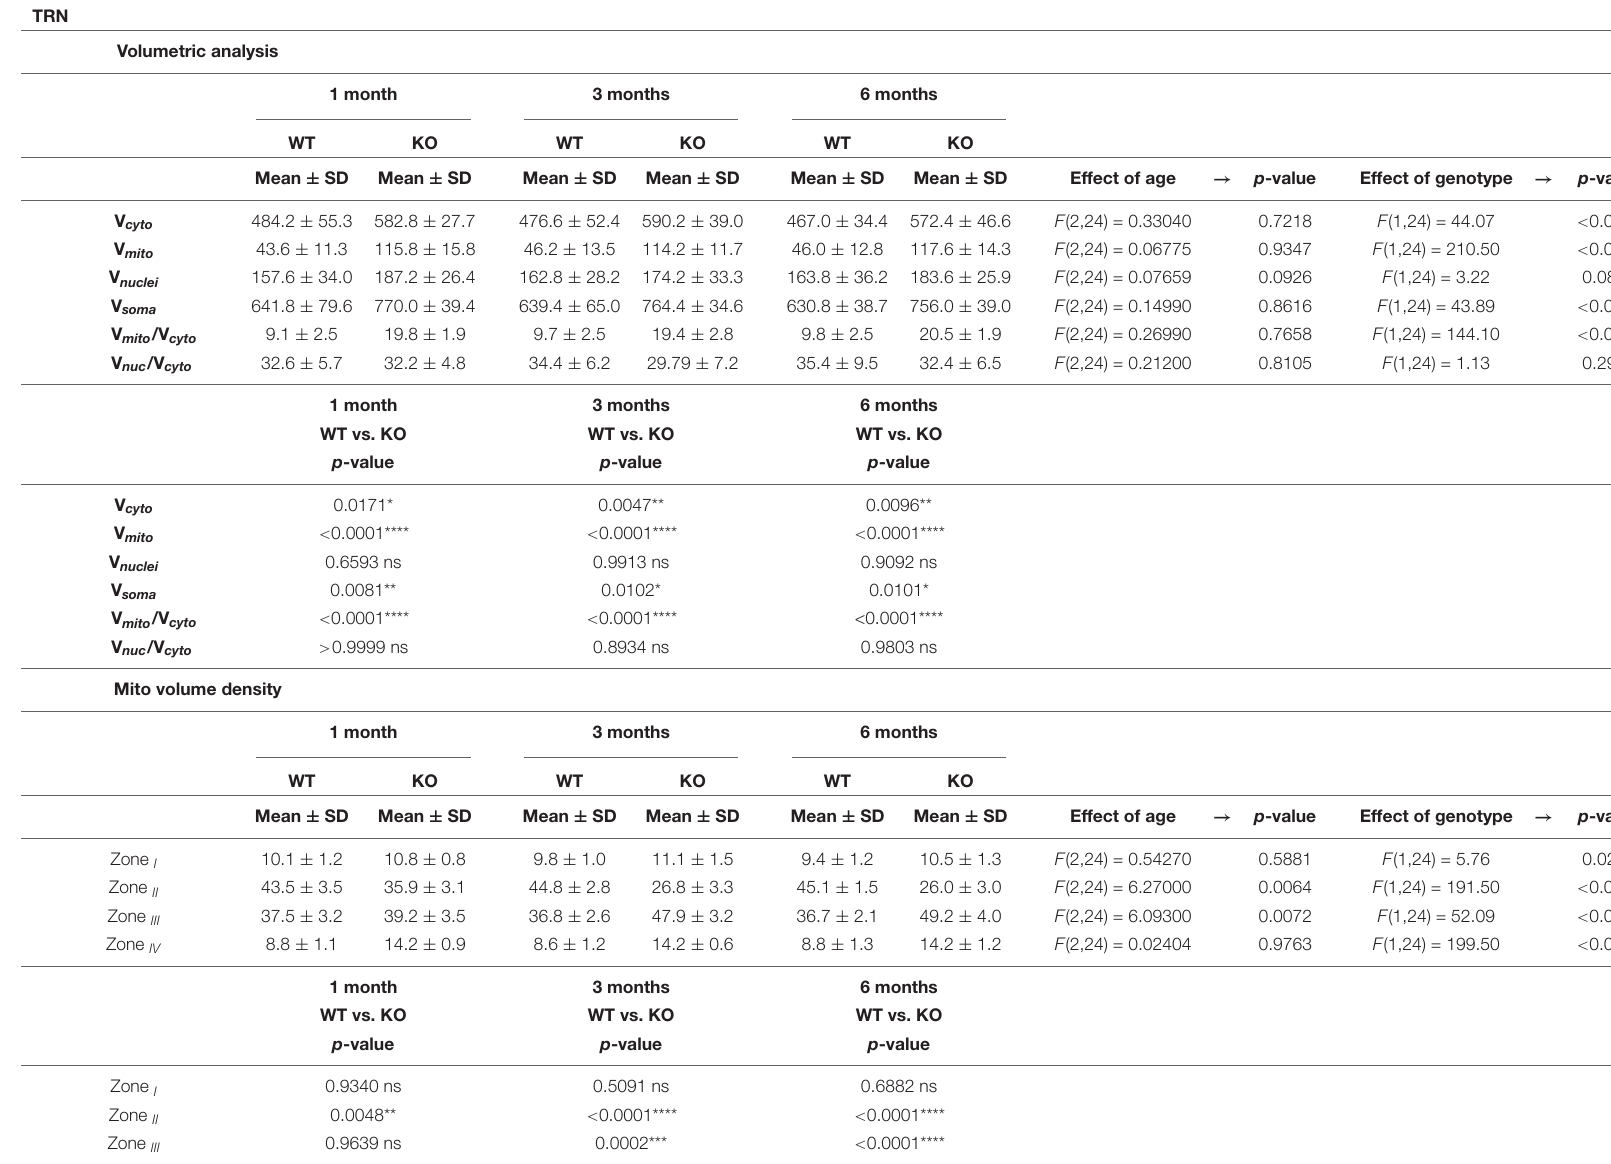
TABLE 2 | Quantitative results and statistical analyses of volumetric analysis and mitochondria position in four zones are shown as Mean ± SD in striatum and TRN.